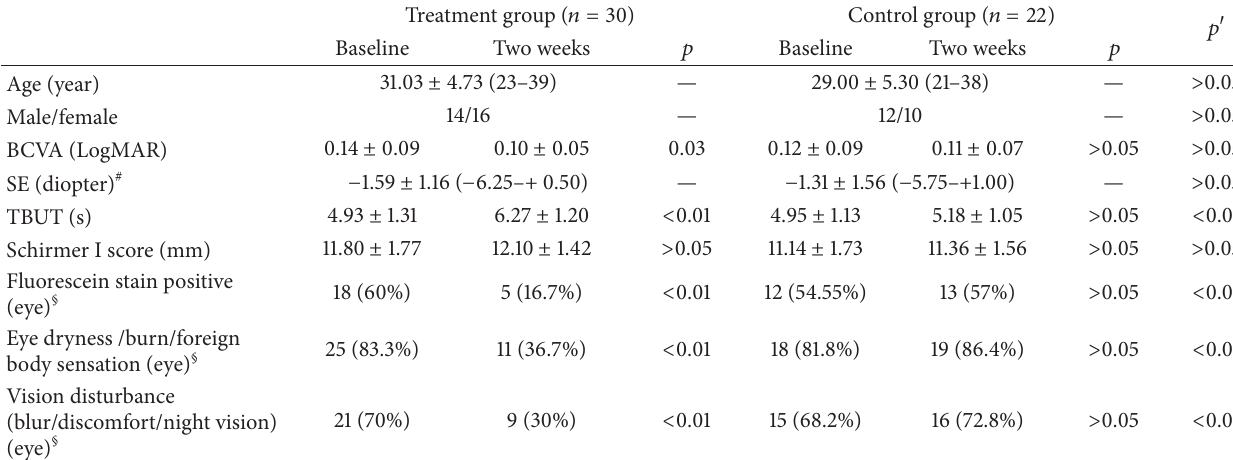
Table 1: Clinical data analysis for the dry eye patients at baseline and two weeks after